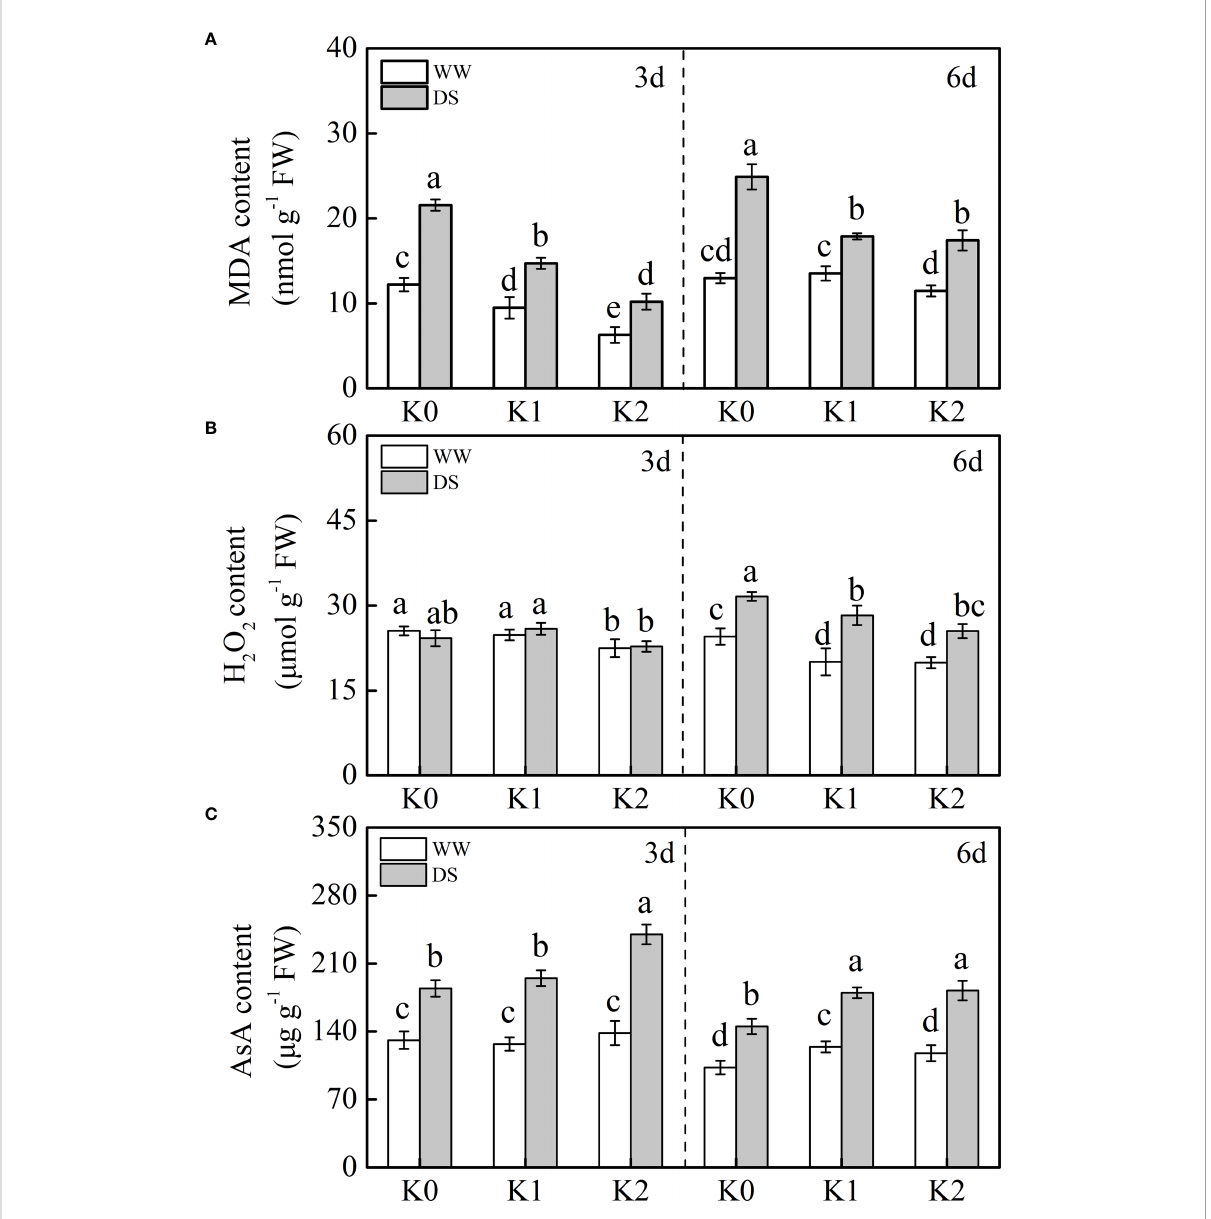
FIGURE 4 Effects of drought stress on MDA (A) , H 2 O 2 (B) , and AsA (C) contents in sesame leaves at the fl owering stage under different K levels. K0, K1, and K2 represent K application rates at 0, 60, and 120 kg ha − 1 K 2 O, respectively. 3 d and 6 d indicate the sample date from the initiation of drought stress. Lowercase letters show signi fi cant differences at the P <0.05